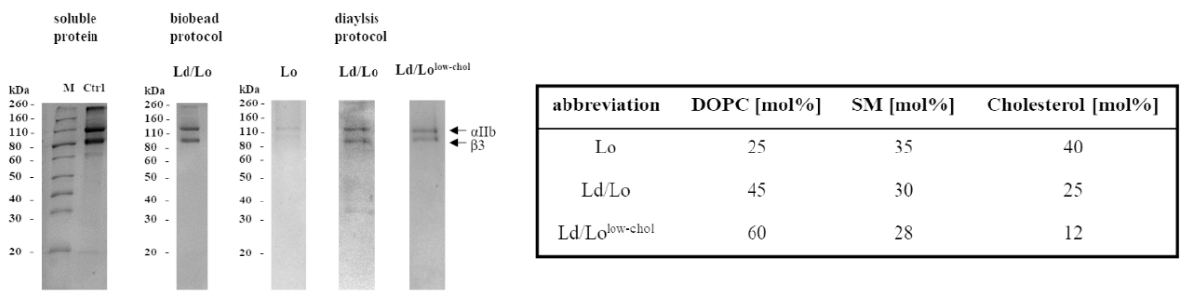
Figure 3. The reconstitution of full-length integrin in several lipid environments as validated by reducing SDS-PAGE. The lipid ratios are specified on the right. Proteoliposomes prepared with the dialysis protocol or the biobead protocol were analysed by SDS-PAGE showing the presence of both integrin subunits with the expected apparent molecular weight of 90 and 110 kDa. Commercial Triton X-100-solubilzed integrin α IIb β 3 (150 µ g/mL) was used as control (Ctrl).